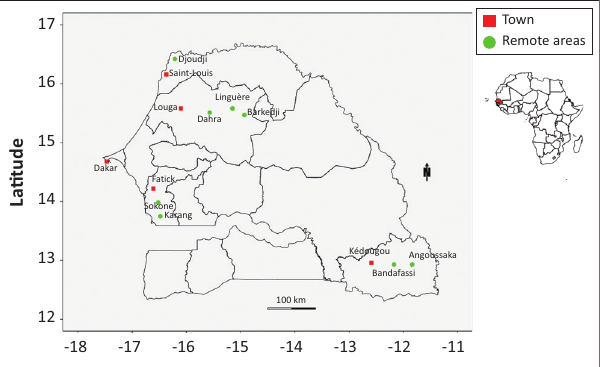
FIGURE 1: Map indicating the study areas in Senegal,